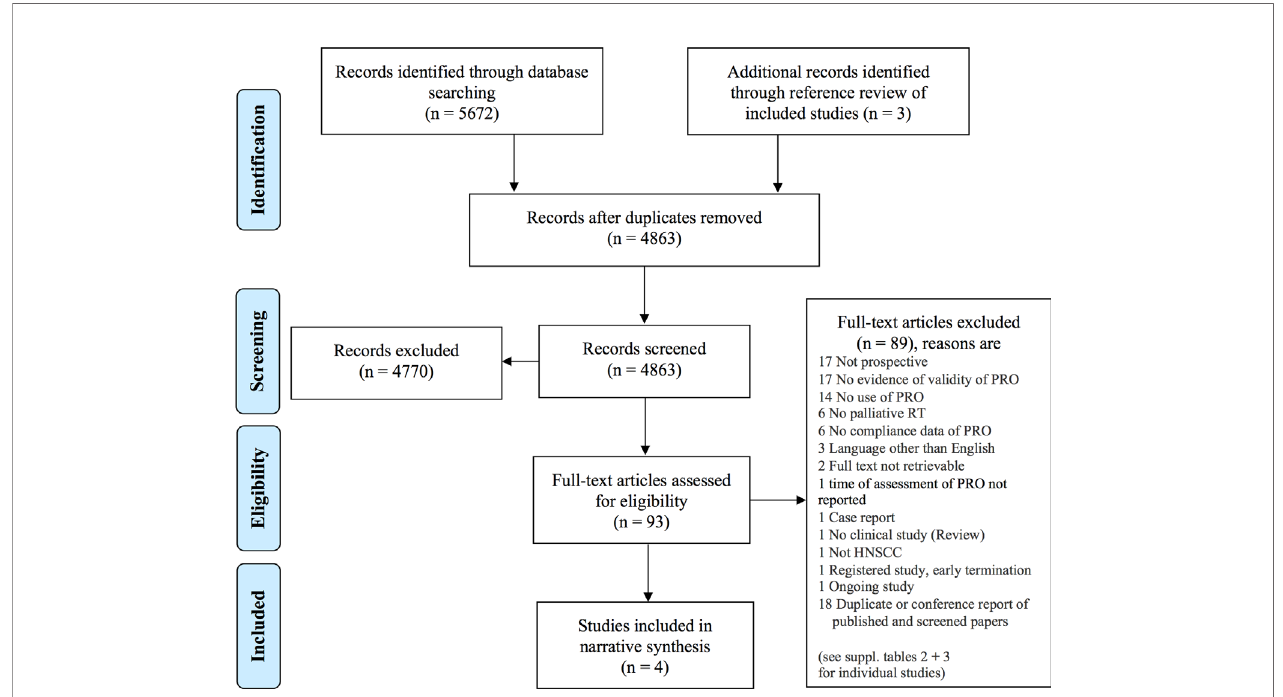
FIGURE 1 | PRISMA fl ow diagram (17). The databases MEDLINE/Pubmed, EMBASE, Cochrane CENTRAL, and “ ClinicalTrials.gov ” were searched. Screening was performed independently by two authors. HNSCC, head and neck squamous cell carcinoma; PRO, patient-reported outcome; RT, radiotherapy.